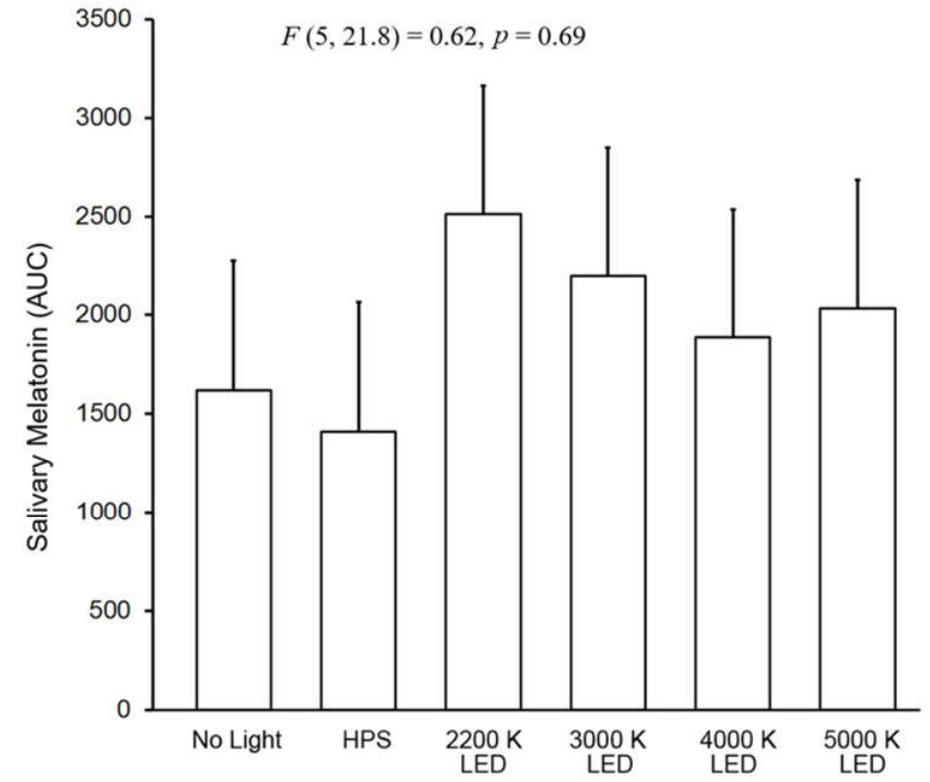
Figure 8. The bars shown above represent the AUC mean salivary melatonin levels (+ SEM) for each of the six roadway lighting condition. The integrated melatonin AUC values were calculated from the raw salivary melatonin values shown in Figure 7 for the exposure period only (1:00 A.M.–3:00 A.M.). The statistics are based on the LMM.